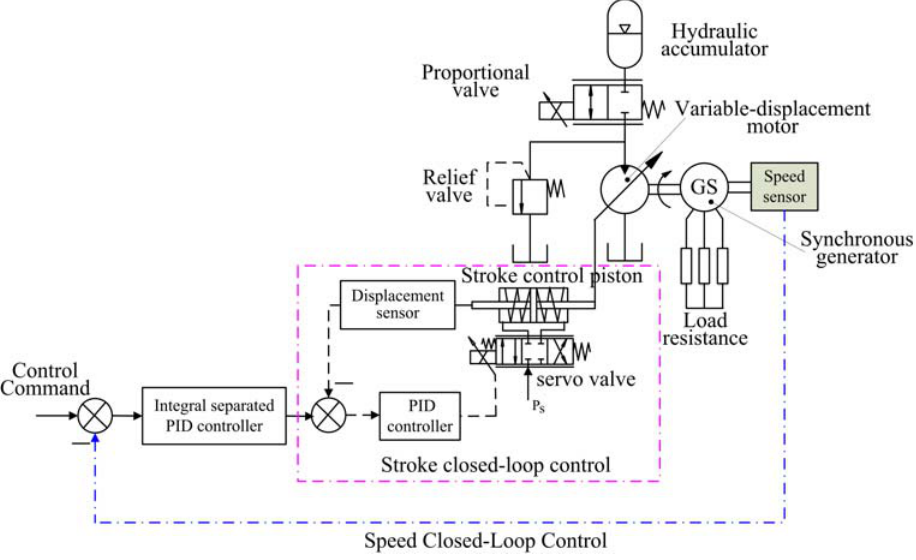
Figure 2. Constant speed control system of the hydraulic energy storage generation system.